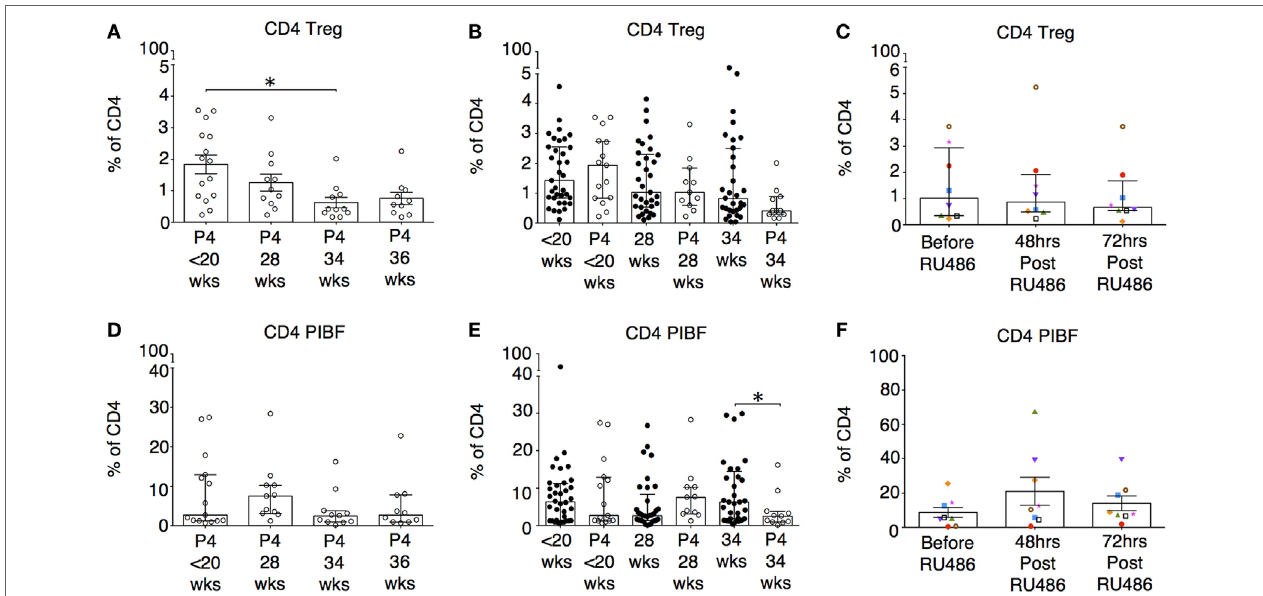
FigUre 11 | The influence of P4 and RU486 on CD4 + regulatory T cell (Tregs) and P4-induced blocking factor (PIBF) expressing CD4 + T cells. (a) Longitudinal analysis of CD4 Treg proportions (CD4 + CD45RO + CD25 + CD127 lo ) in peripheral blood obtained from P4 treated patients. (B) Gestation-matched paired comparisons of Treg proportions in peripheral blood obtained from P4 treated versus untreated pregnant controls that were previously analyzed longitudinally in Figure 3c . (c) Longitudinal analysis of Treg proportions in peripheral blood obtained from RU486 treated pregnant patients. (D) Longitudinal analysis of PIBF expressing CD4 T cells in peripheral blood obtained from P4-treated patients. (e) Gestation matched paired comparisons of PIBF expressing CD4 T cells in peripheral blood obtained from P4 treated versus untreated pregnant controls (Unpaired Mann–Whitney U test). (F) Longitudinal analysis of PIBF expressing CD4 T cells in peripheral blood obtained from RU486-treated pregnant patients. Gestation at sampling is indicated: in pregnant controls ( ⚫ ) at < 20 + 0 weeks ( N = 42 ), 28 weeks ( N = 35 ), 34 weeks ( N = 33 ); and P4 treated pregnancies ( ′ ) at < 20 + 0 weeks ( N = 15 ), 28 weeks ( N = 11 ), 34 weeks ( N = 11 ), 36 weeks ( N = 10 ). For RU486 treated ( N = 8 ) symbols represent individual patients. Longitudinal data were analyzed with either one-way ANOVA with Tukey’s post hoc correction or Freidman test with Dunn’s post hoc correction depending on the data distribution. P values are two tailed and significance is defined as * P <